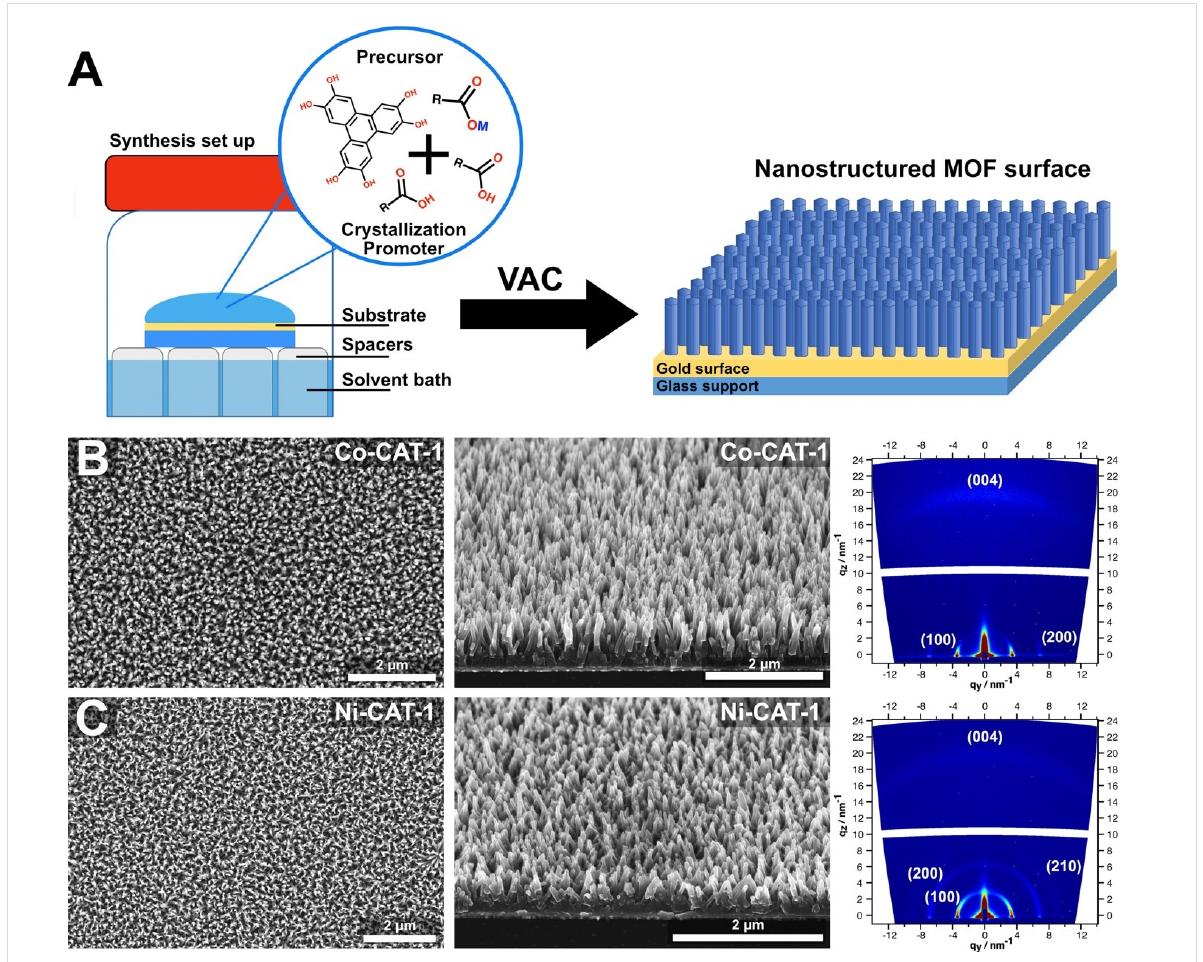
Figure 2: A) A scheme of the vapor-assisted conversion (VAC) set up and the resulting nanostructured films. B) SEM top view, 30° tilted cross- section and the related GIWAXS pattern of the Co-CAT-1 film. C) SEM top view, 30° tilted cross-section momographs and the related GIWAXS pattern of the